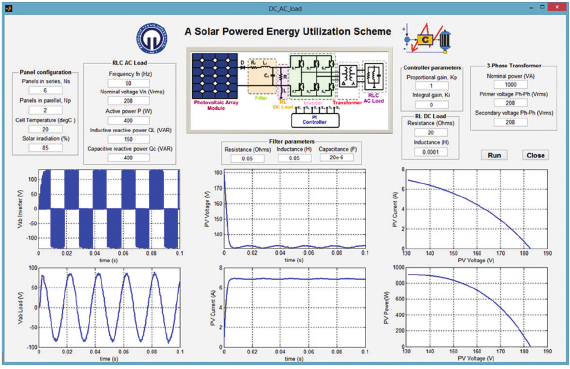
Figure 6: The PV powered AC loads